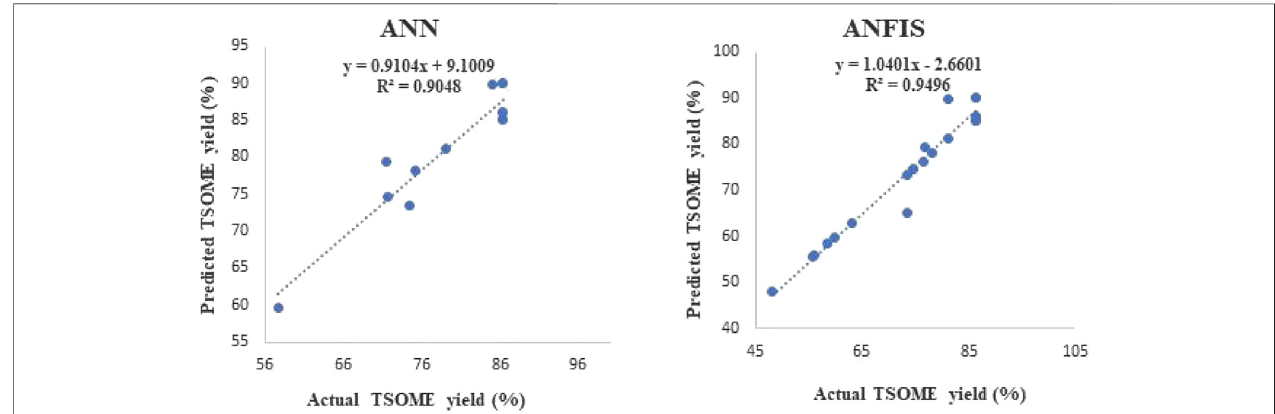
FIGURE 13 | Comparison of actual and predicted ANN and ANFIS yield: (A) Actual and ANN predicted yields and (B) actual and ANFIS predicted yields.